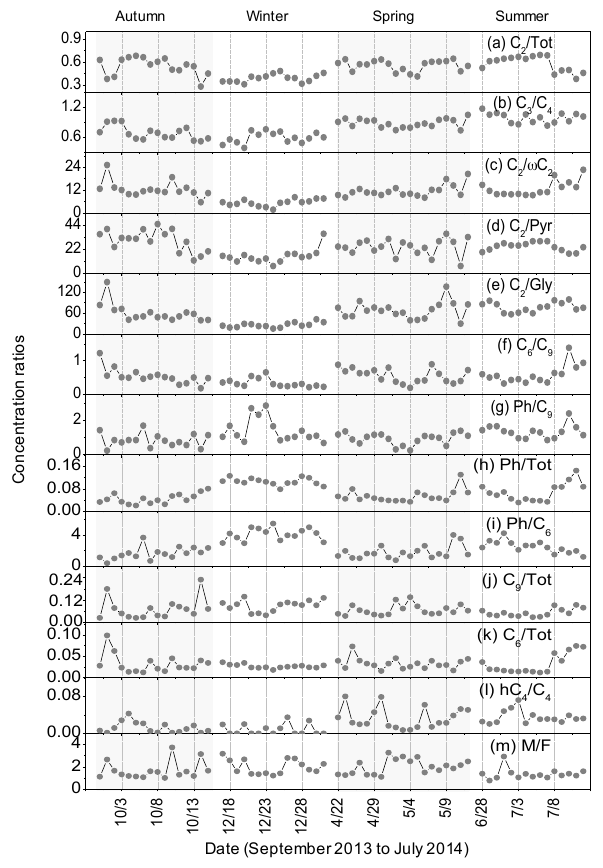
Figure 4. Seasonal variations in the concentration ratios of (a) C 2 / Tot, (b) C 3 / C 4 , (c) C 2 /ω C 2 , (d) C 2 / Pyr, (e) C 2 / Gly, (f) C 6 / C 9 , (g) Ph / C 9 , (h) Ph / Tot, (i) Ph / C 6 , (j) C 9 / Tot, (k) C 6 / Tot, (l) hC 4 / C 4 and (m) M / F in the Beijing aerosols.